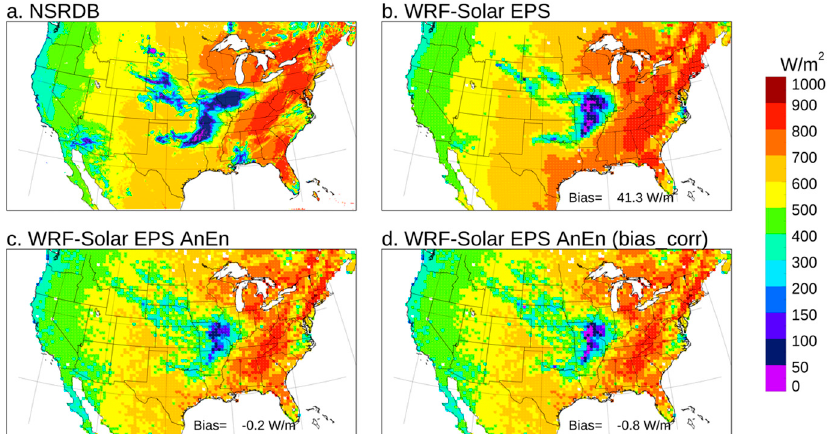
Figure 11. NSRDB GHI map ( a ) at 1530 UTC on July 29, 2018. Model predictions from the ensemble mean of WRF-Solar EPS ( b ), WRF-Solar EPS AnEn ( c ), and WRF-Solar EPS AnEn with bias correction ( d ) are also reported for the same date.